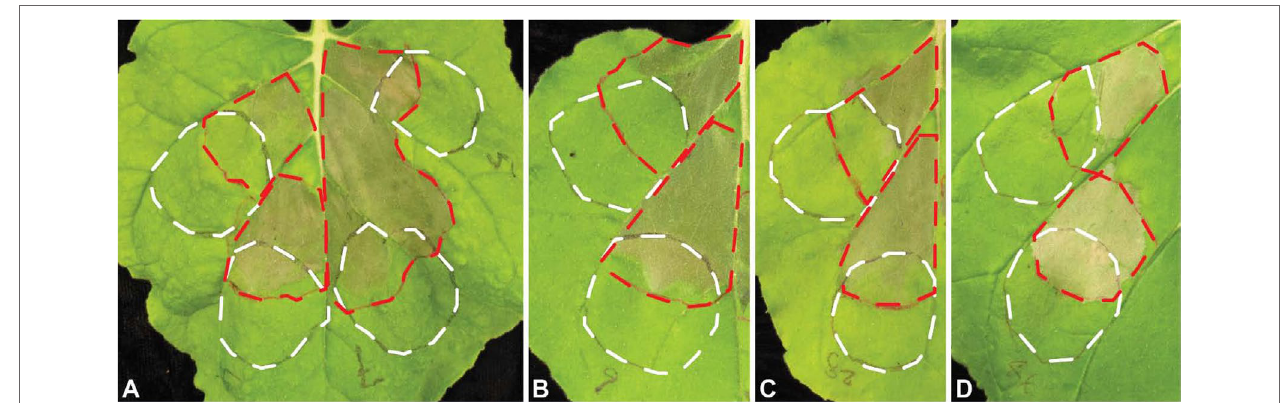
FIGURE 2 | Suppression of basal defense by Uaca_Ns. The white dashed lines show an outline of the patches infiltrated with P. fluorescens strain EtHAn with empty pEDV6 vector control or expressing Uacas from pEDV6, and the red dashed lines show the patches infiltrated with Pst DC3000 seven hours later. (A) left upper patch, EtHAn with empty vector control; left lower patch, EtHAn with Uaca_4; right upper patch, EtHAn with Uaca_5; right lower patch, EtHAn with Uaca_7; (B , C , D) upper patch, EtHAn with empty vector control; lower patch, EtHAn with Uaca_9 (B) , Uaca_28 (C) , and Uaca_44 (D) . The inoculum density of EtHAn strains and Pst DC3000 strains was adjusted to OD 600nm = 0.2 and 0.02, respectively. Images were taken 48 hpi of EtHAn strains. At least three independent repeats of this assay were performed for each Uaca_N.